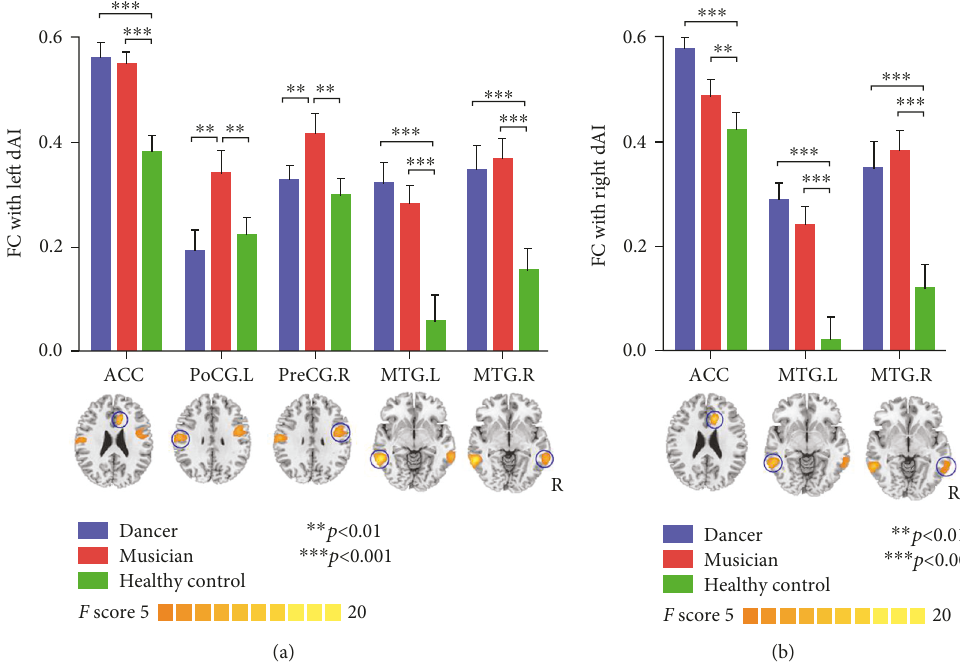
Figure 3: Functional connectivity of dAI seeds. (a) Represents the results of the left dAI, and (b) represents the results of the right dAI. A signi fi cant increase in FC between dAI and ACC and left MTG is observed in dancers and musicians compared with controls. Only in the musician group is there a signi fi cantly higher FC between dAI and left postcentral and right precentral